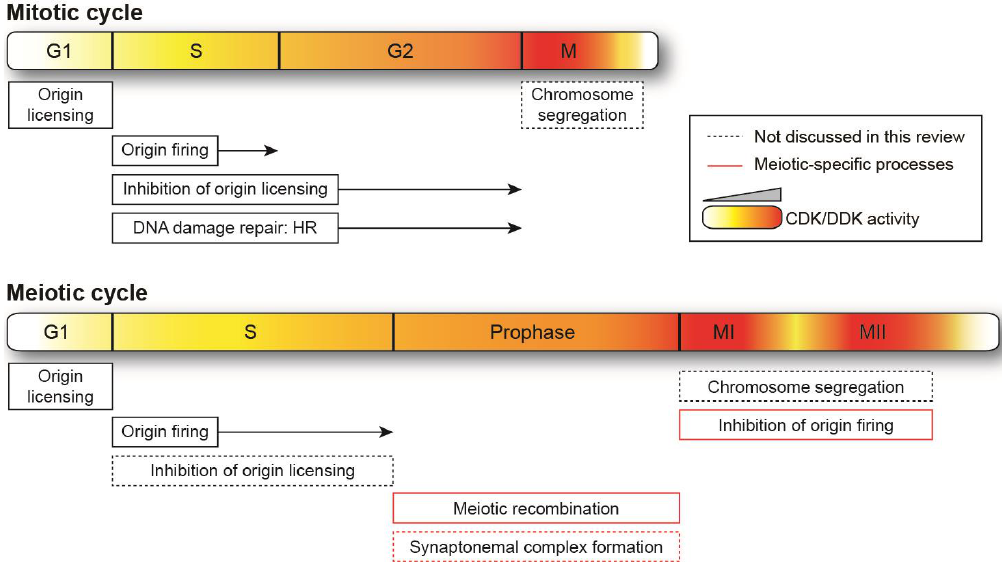
Figure 1. Schematic representation of mitotic and meiotic cycles. Relative changes in cyclin-dependent kinase (CDK) and Dbf4-dependent kinase (DDK) activity are illustrated by the intensity of the gradient (yellow-red), with more intense red denoting higher levels. For ease of visualization, the higher activities required in meiosis vs. mitosis are not depicted. The lengths of the cell cycle phases are not shown to scale. HR: homologous recombination. Meiosis-specific events are highlighted in red boxes, and processes that are not discussed in this review are indicated by dotted lines.